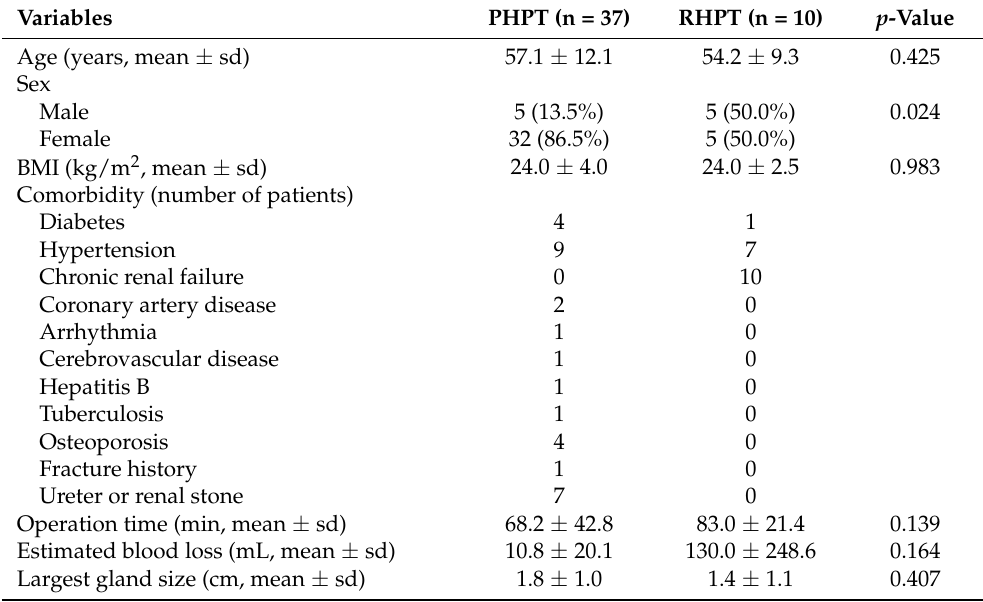
Table 2. Comparison between primary and renal (secondary and tertiary)